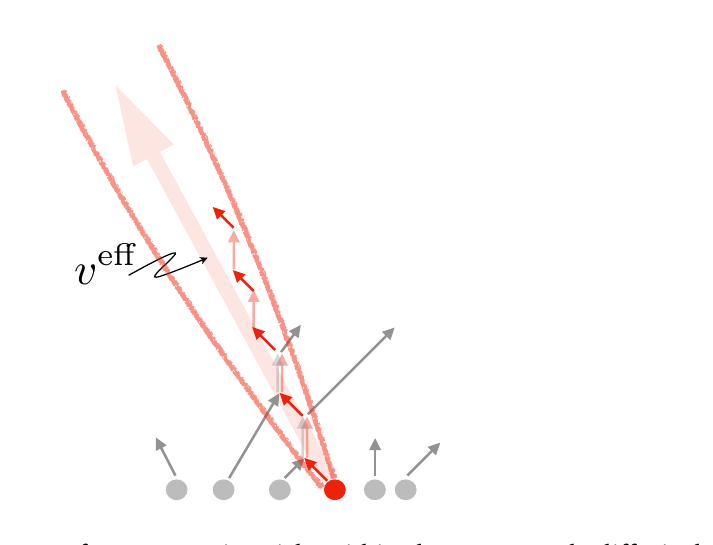
Figure 18: The trajectory of a test quasiparticle within the gas spreads diffusively around its velocity v eff